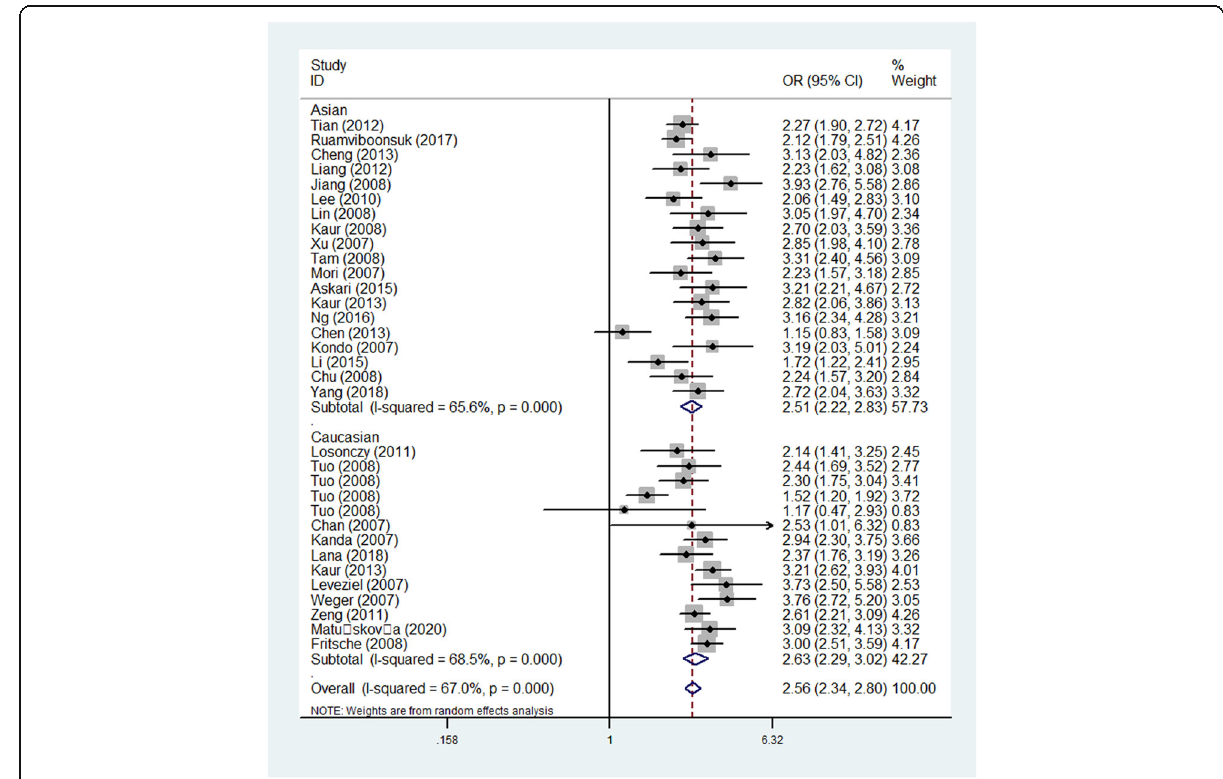
Fig. 4 Forest plot of AMD risk associated with HTRA1 gene rs11200638 polymorphism (A-allele vs. G-allele) by ethnicity